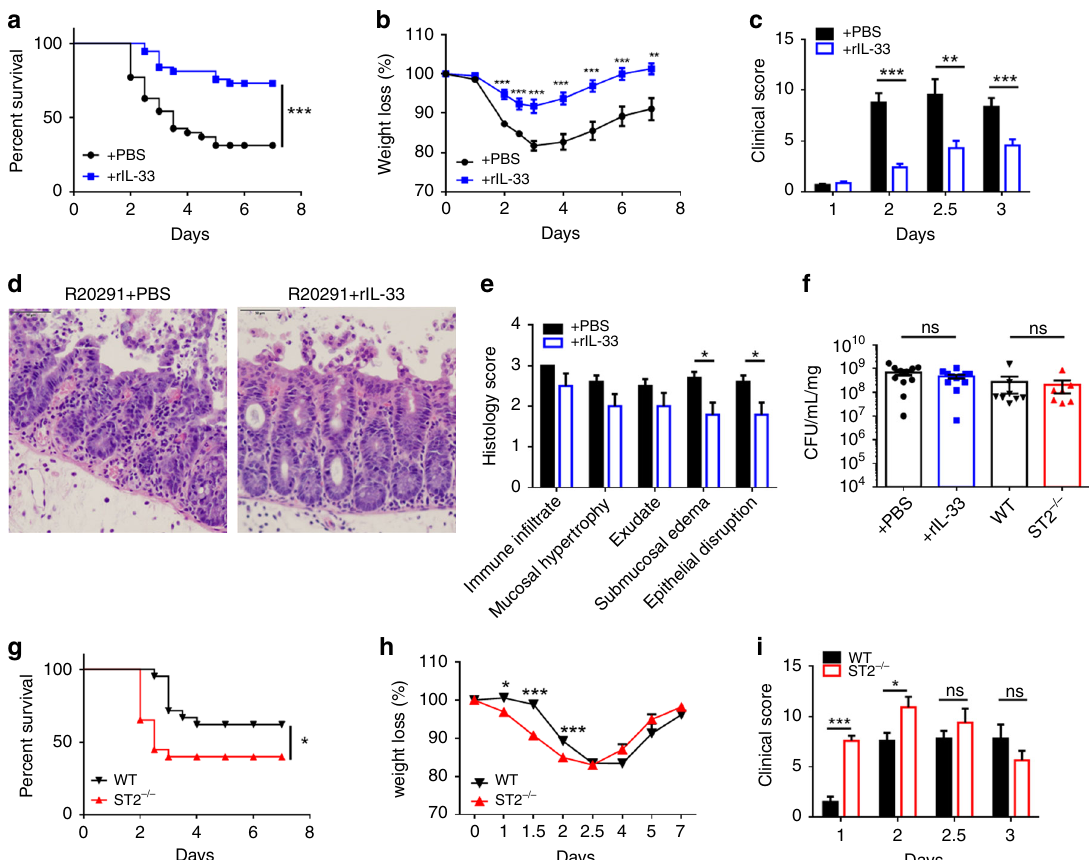
Fig. 2 IL-33 protects from mortality and epithelial barrier disruption during C. dif fi cile infection. C57BL6 mice ( a – f ) or ST2 − / − mice ( f – i ) were treated with an antibiotic cocktail prior to infection with R20291 and treated by IP injection with recombinant IL-33 (rIL-33) or vehicle control (PBS) for 5 days prior to infection. a Survival curves ( b ), weight loss ( c ), and clinical scores after infection and treatment. ( d , e ) Infected cecal tissue was examined with IL-33 treatment and without (day 3). d Representative epithelial damage (H&E) of treatment groups assessed by ( e ) blinded scoring of infected tissue (H&E). f Peak C. dif fi cile bacterial burden in cecal contents after infection (day 2) of IL-33-treated mice or ST2 − / − mice compared with the vehicle or wild-type controls. g – i ST2 − / − on C57BL6 background and C57BL6 controls were cohoused for 3 weeks prior to R20291 infection. g Survival curves ( h ) weight loss and ( i ) clinical scores were assessed. a , g Comparison made by log rank test ( a , n = 35, 37; g , n = 21, 20). b – e , h – i Comparison made by Student's t test ( b , n = 39; c , n = 29, 30; e , n = 10; h , n = 27, 26; i , n = 20). f Comparisons for C. dif fi cile burden were made by Mann – Whitney U tests ( f , n = 11, 12, 8, 7). a – c , g – i The data combined from three independent experiments. d – f The data representative of three independent experiments. Statistical signi fi cance is demarked as * P < 0.05, ** P < 0.01, and *** P < 0.001. Scale bar is 50 μ m. Error bar indicates